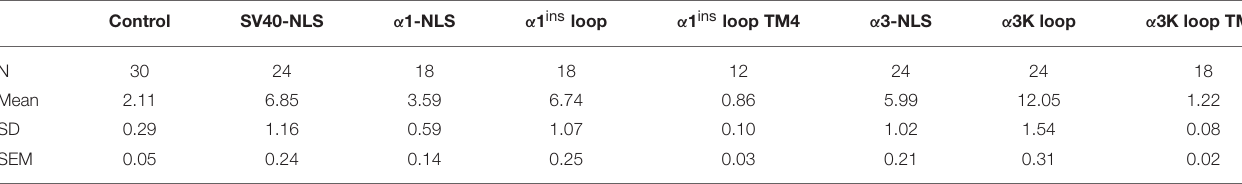
TABLE 1 | Assessment of nuclear targeting capacity of large cytosolic GlyR loop domains.